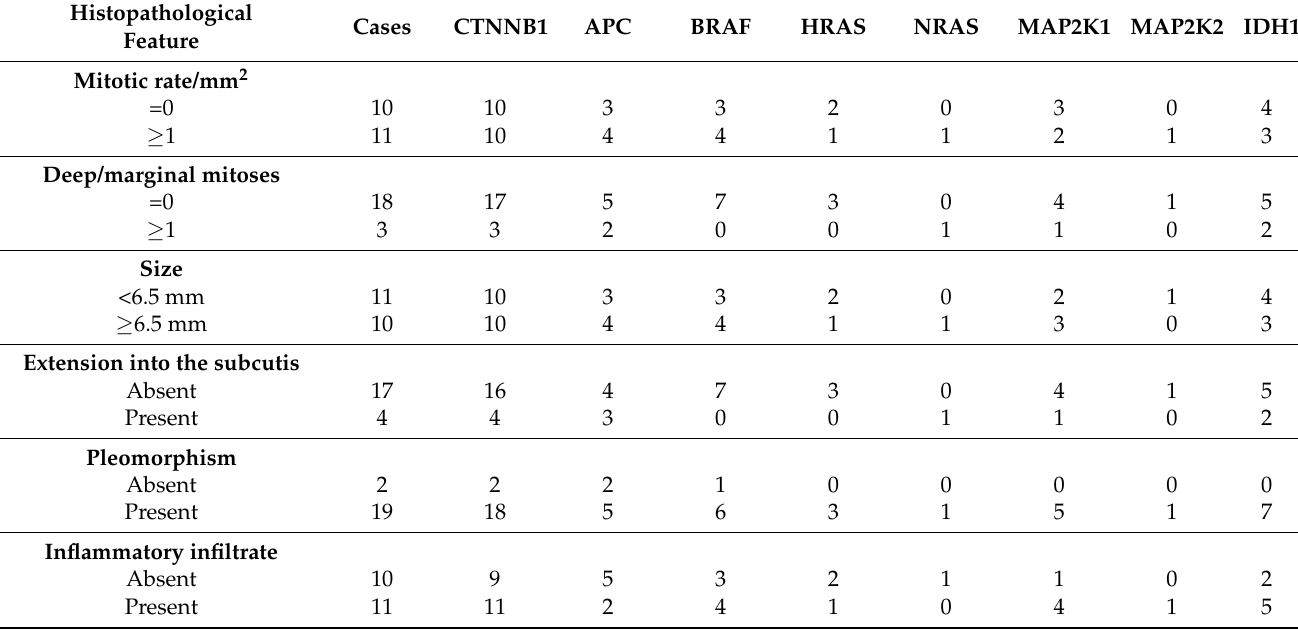
Table 4. Correlations between histopathological features and driver gene mutations in 21 atypical DPNs.